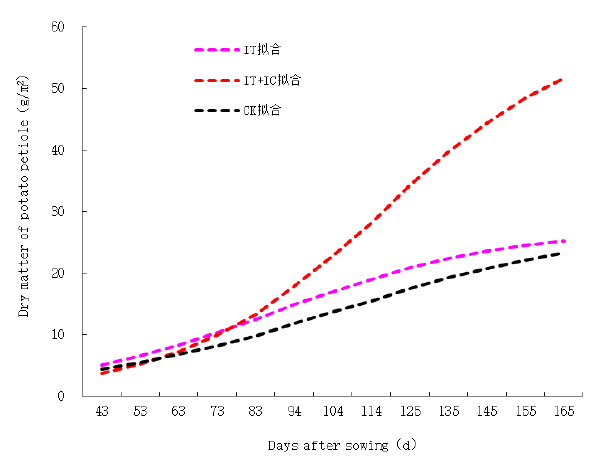
Figure 2: Dynamic simulation curve of dry matter accumulation for potato petiole in different